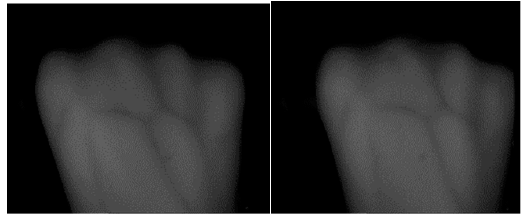
Figure 16. Difference in displacement. Figure 16. Di ff erence in displacement.